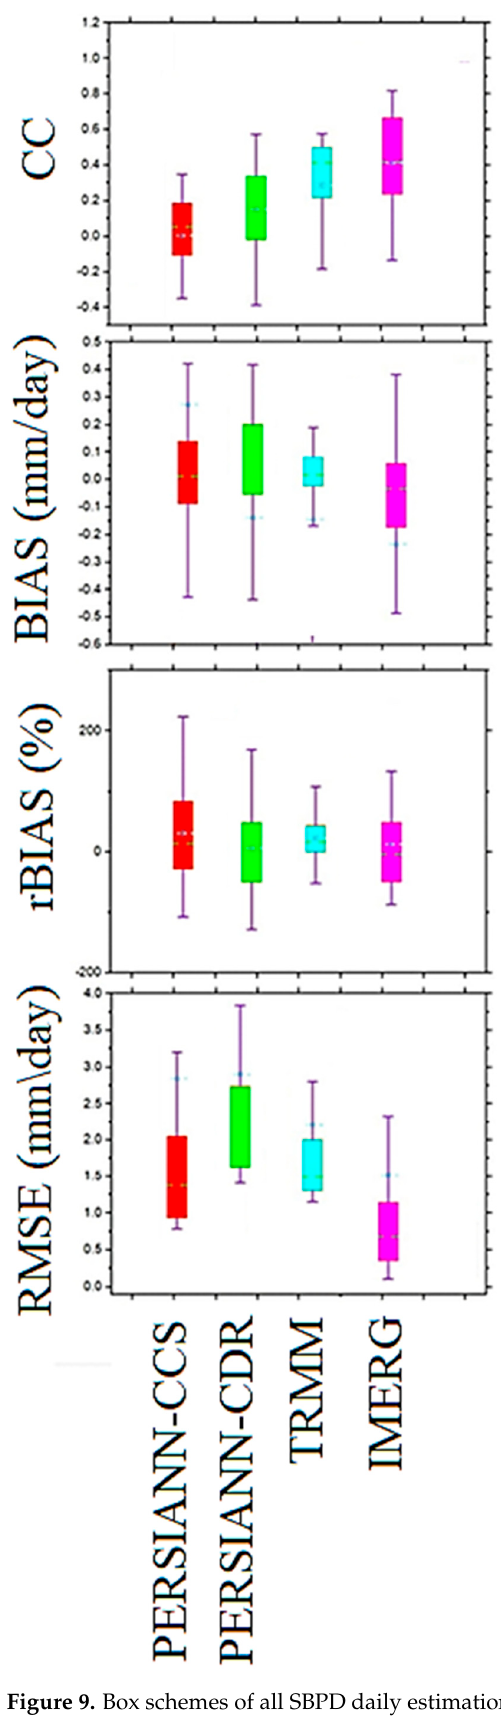
Figure 9. Box schemes of all SBPD daily estimations.